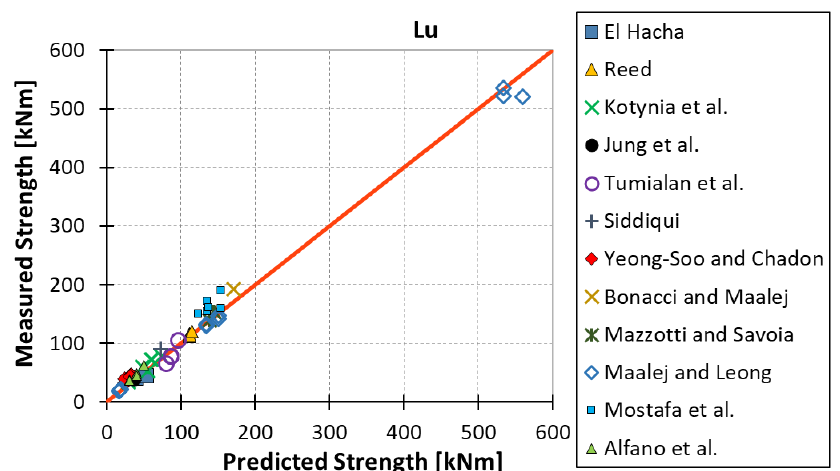
Figure 6. Measured flexural strength versus Lu model prediction.